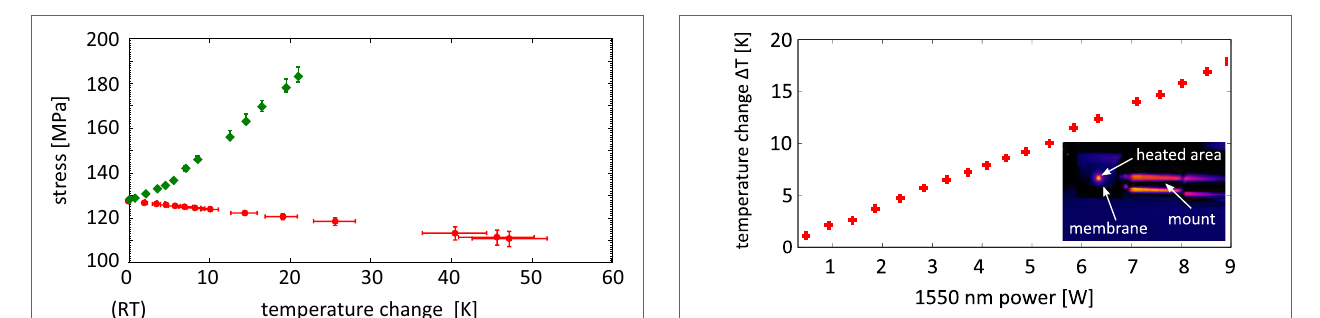
FIGURE 7 | Change in stress as a function of membrane temperature change ∆ T (at position 3) starting from room temperature (RT): the green diamonds show the resulting stress when heating the frame with the 532nm laser. The red circles show the stress for heating the center of the membrane with the 1,550nm beam.